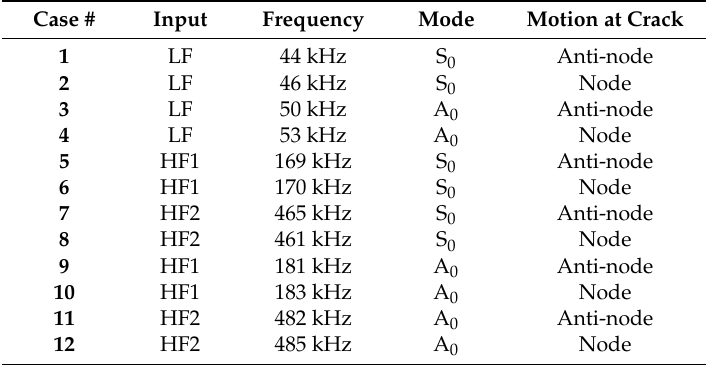
Table 1. Input frequencies determined by experimental modal analysis.